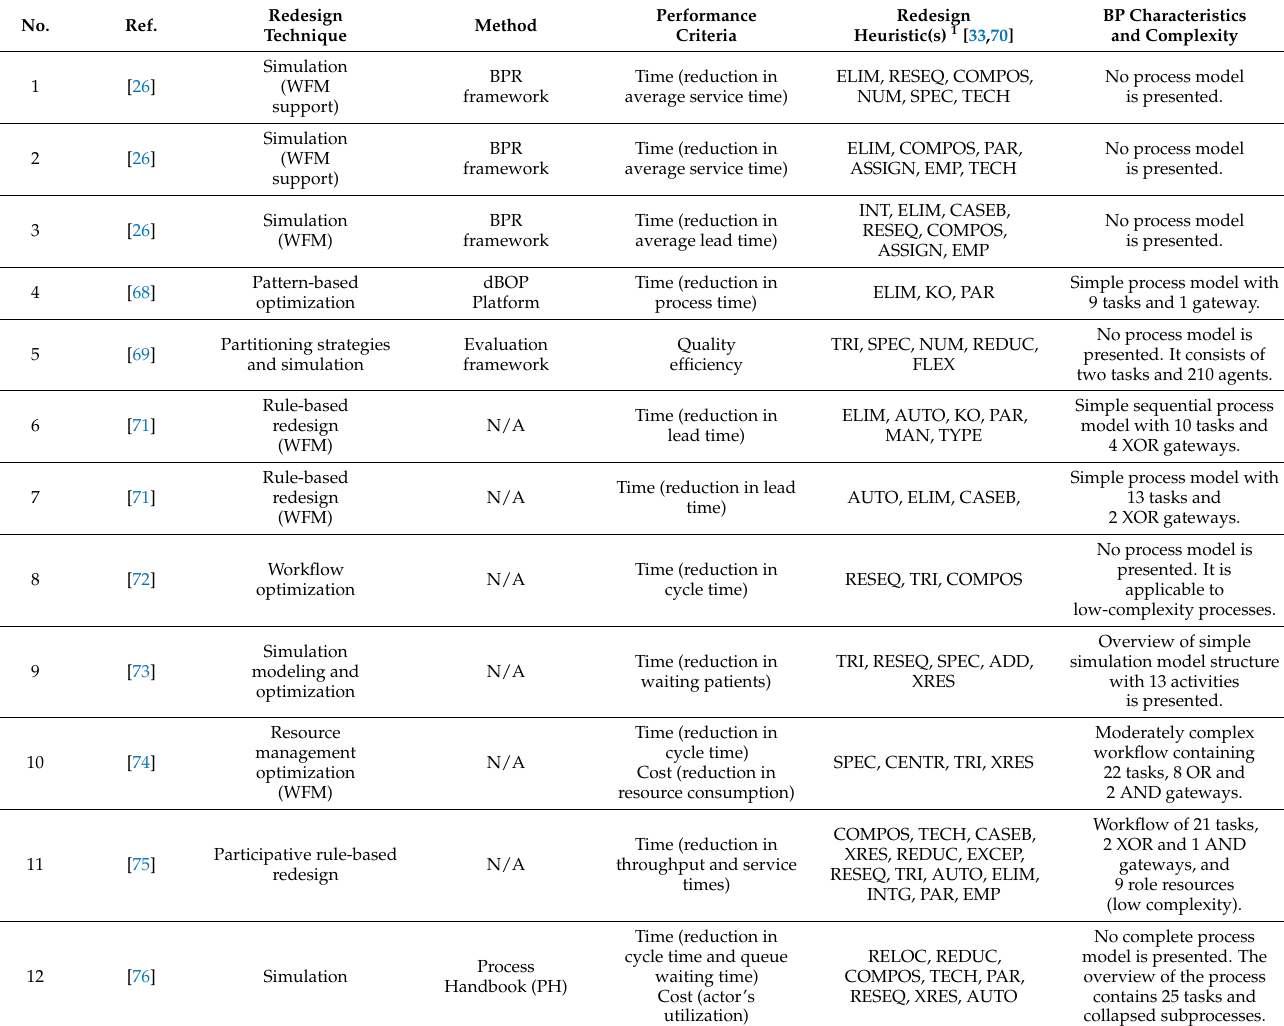
Table 2. Existing business process redesign initiatives compared to BP-RCA